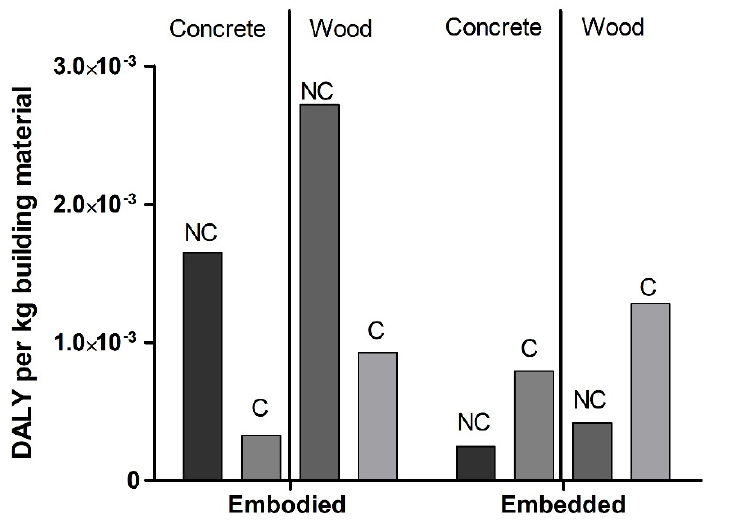
Figure 6. The initial embodied and embedded human toxicity impact given for carcinogenic (C) and non-carcinogenic (NC) effects in DALY per kg of building material. The initial embodied and embedded human toxicity impact is separated between concrete and wood. The initial embedded and embodied impact is provided in kg which cannot be translated into a construction context.